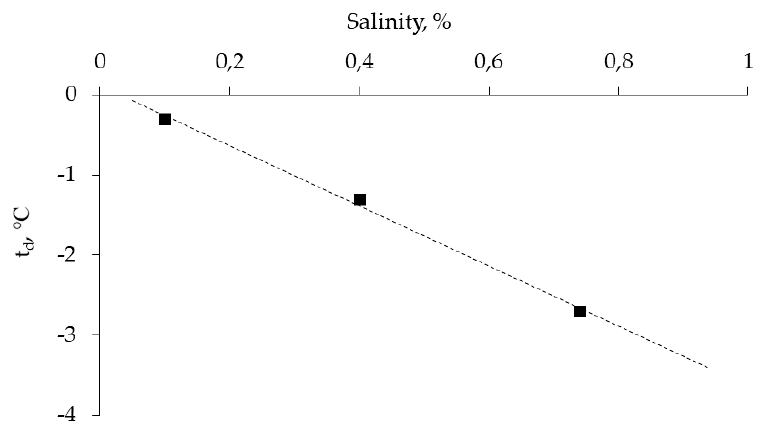
Figure 5. Temperature of rapid hydrate dissociation onset ( t d ) in frozen hydrate-bearing samples as a function of salinity.